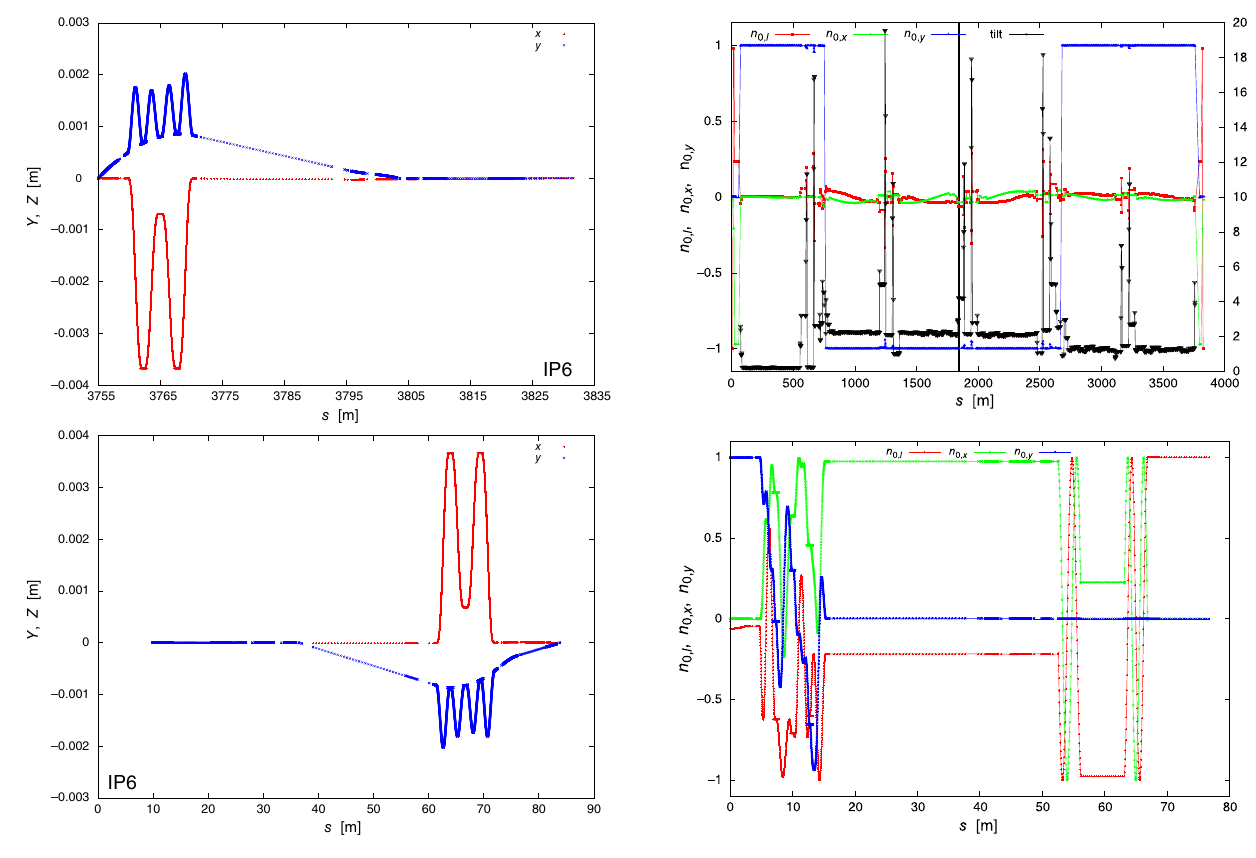
FIG. 29. Top: Polarization ( ⃗ n 0 vector components, left axis) around RHIC Yellow ring, and ⃗ n 0 tilt angle to vertical (right axis). Run 22 store optics (255 GeV), the lattice includes the 16 snake and rotator field maps. The ⃗ n 0 tilt spikes are located at the vertical orbit separation bumps at IPs. Bottom: details of ⃗ n 0 components in IR6 region, from vertical spin at YI6_B3 rotator entrance (at s ¼ 0 in this graph) to longitudinal at IP6 ( s ≈ 77